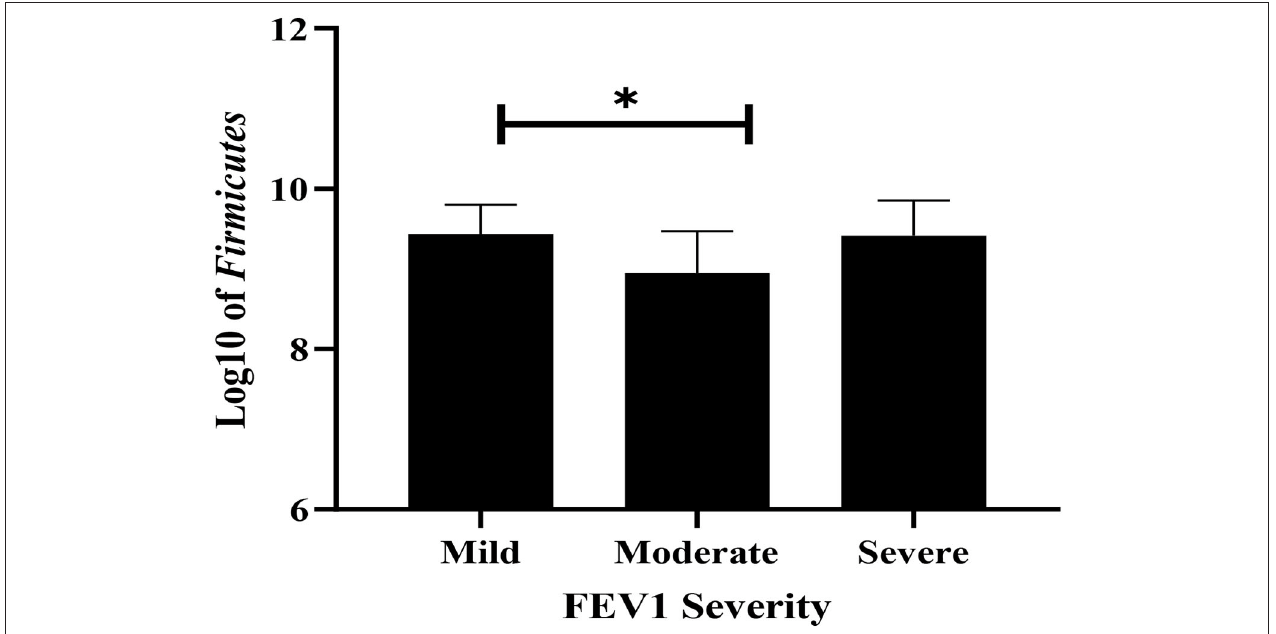
FIGURE 4 | The difference of Firmicutes among mild, moderate, and severe airway obstruction using ANOVA. Values are shown as mean and SD of log-transformed genome copies/g of fecal sample. * P <